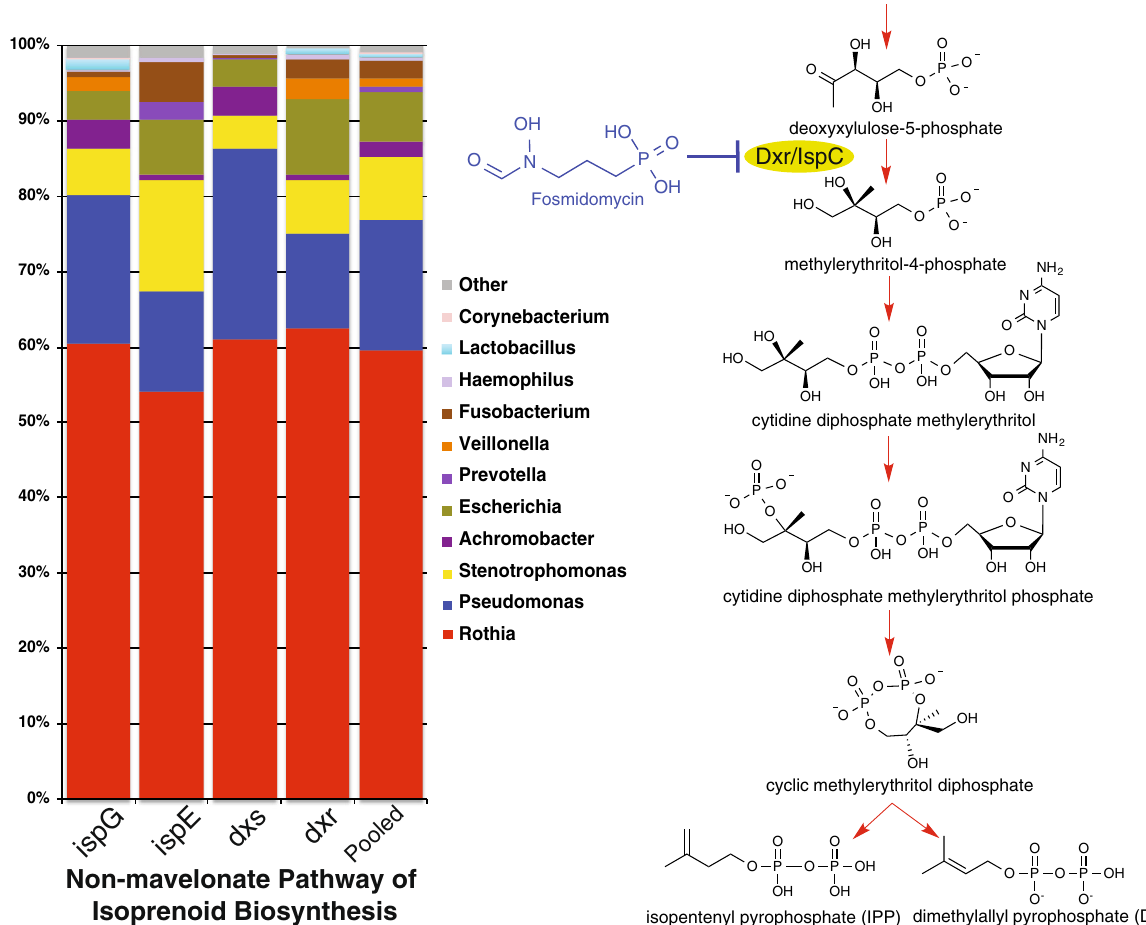
Fig. 5 Read mapping of the non-mevalonate pathway reads in CF metagenomes in the context of the chemical species and steps of the pathway. The action of the antibiotic fosmidomycin is shown as a